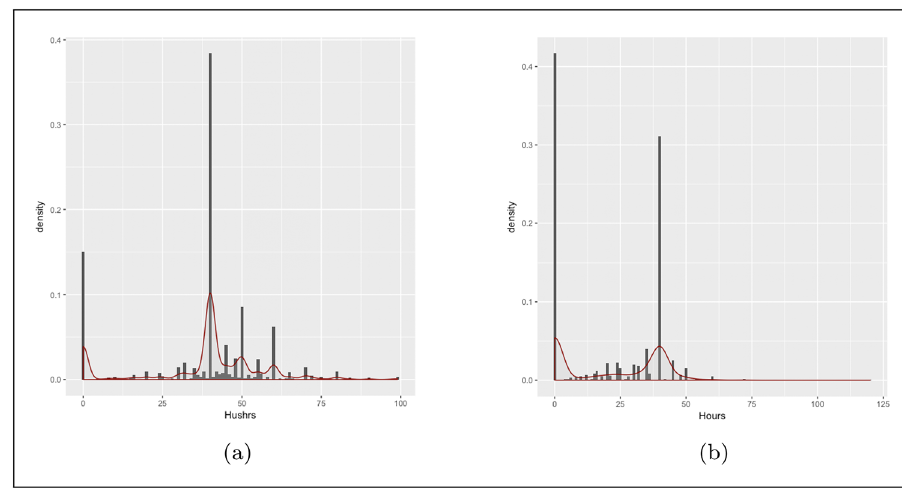
Figure 5: Histogram of marginal distributions with estimated density. ( a ) Hushrs variable. ( b ) Hours